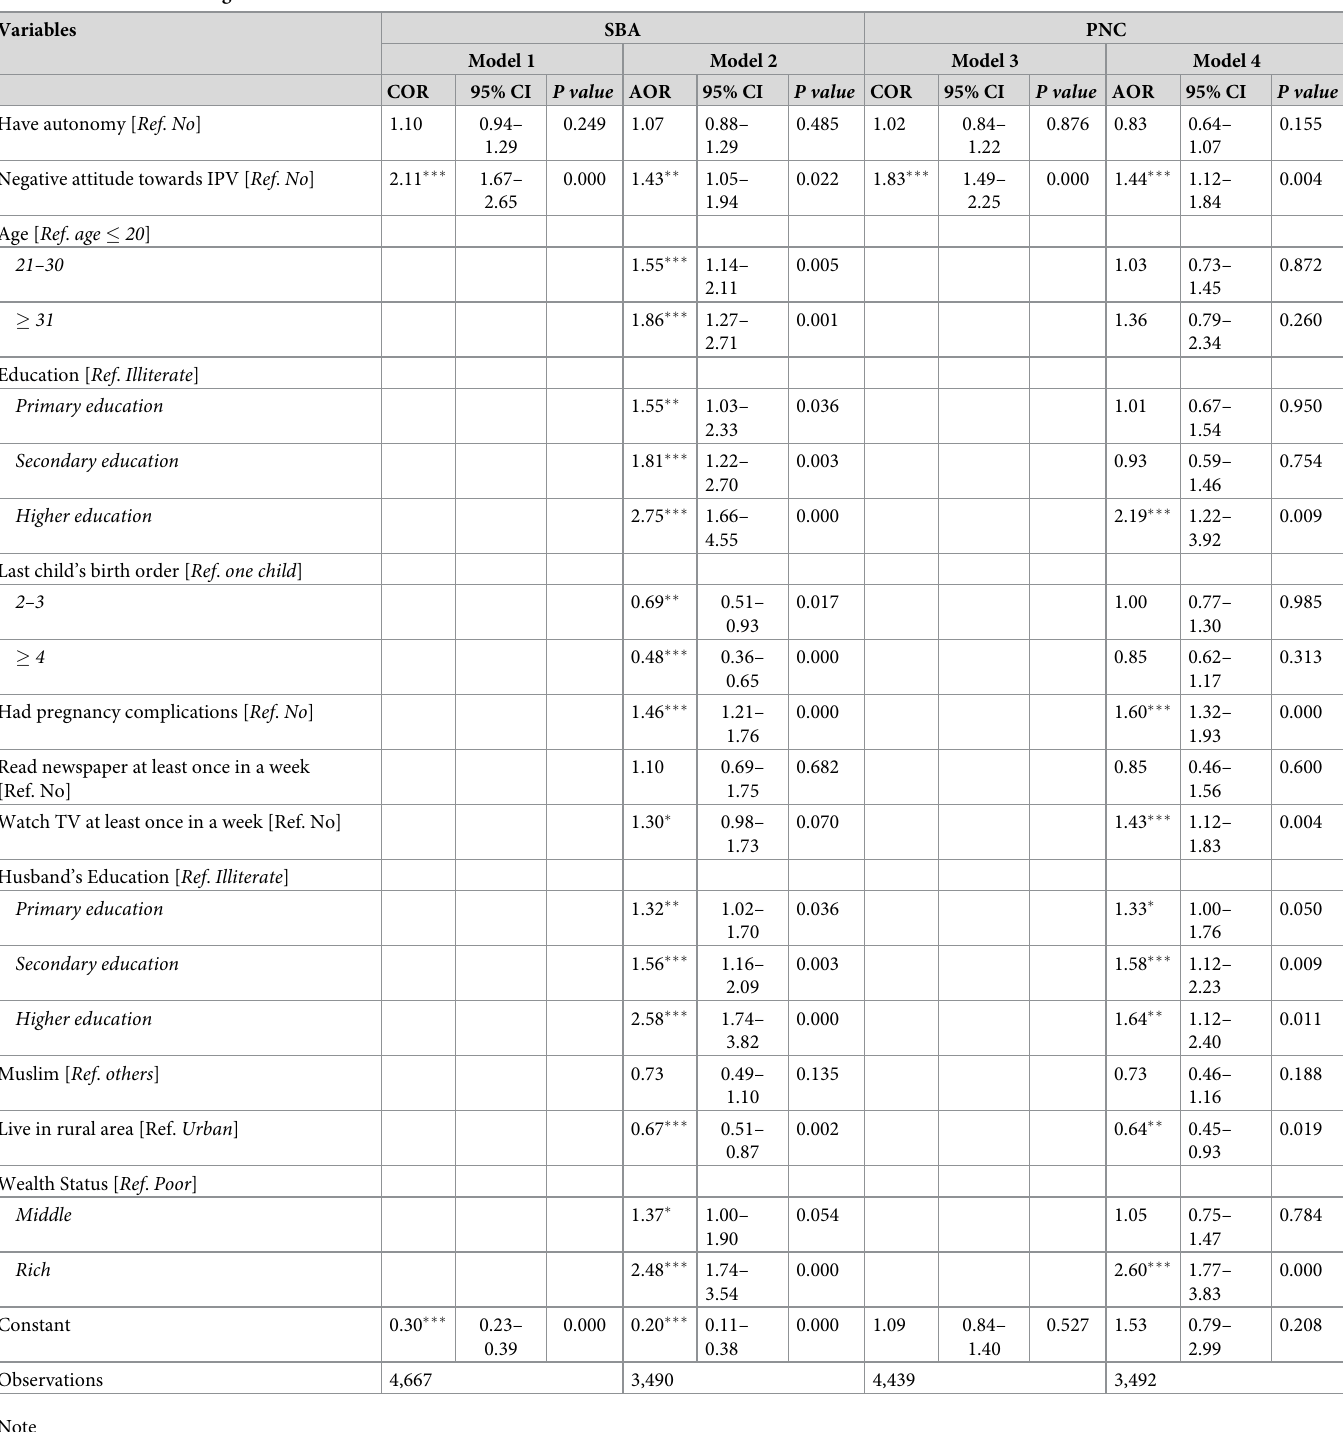
Table 3. Factors influencing access to and utilization of SBA and PNC